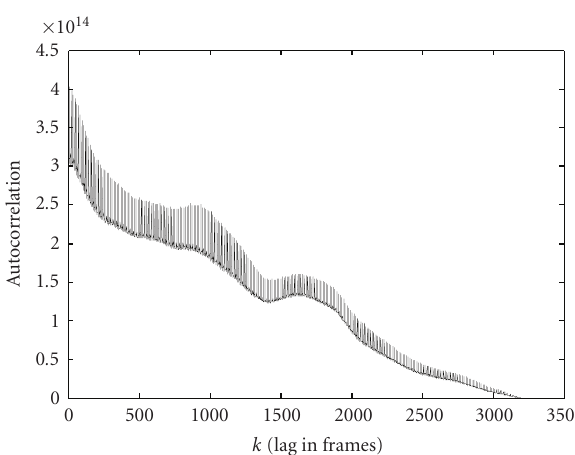
Figure 7: ACF of picture size in “The Living Sea” video sequence encoded with a constant